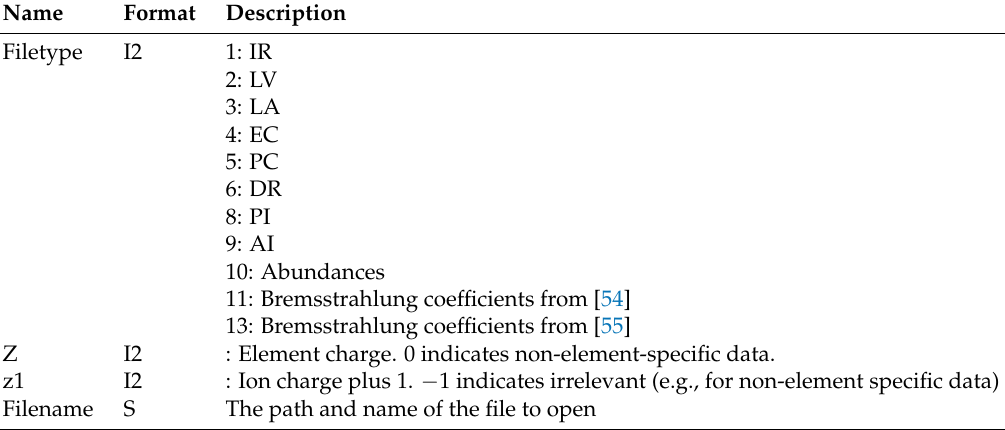
Table A11. APED filemap file definition. This is a text file which denotes which files were used in an APEC run to create the emissivity files. It is used to identify the current recommended data in the database. Each line indicates another file, with the contents of each line being four columns, in the format “I2XI2XI2XS”. I2 is a two character integer, S is a string of unspecified length, and X is a white space character. Each column represents, from left to right: